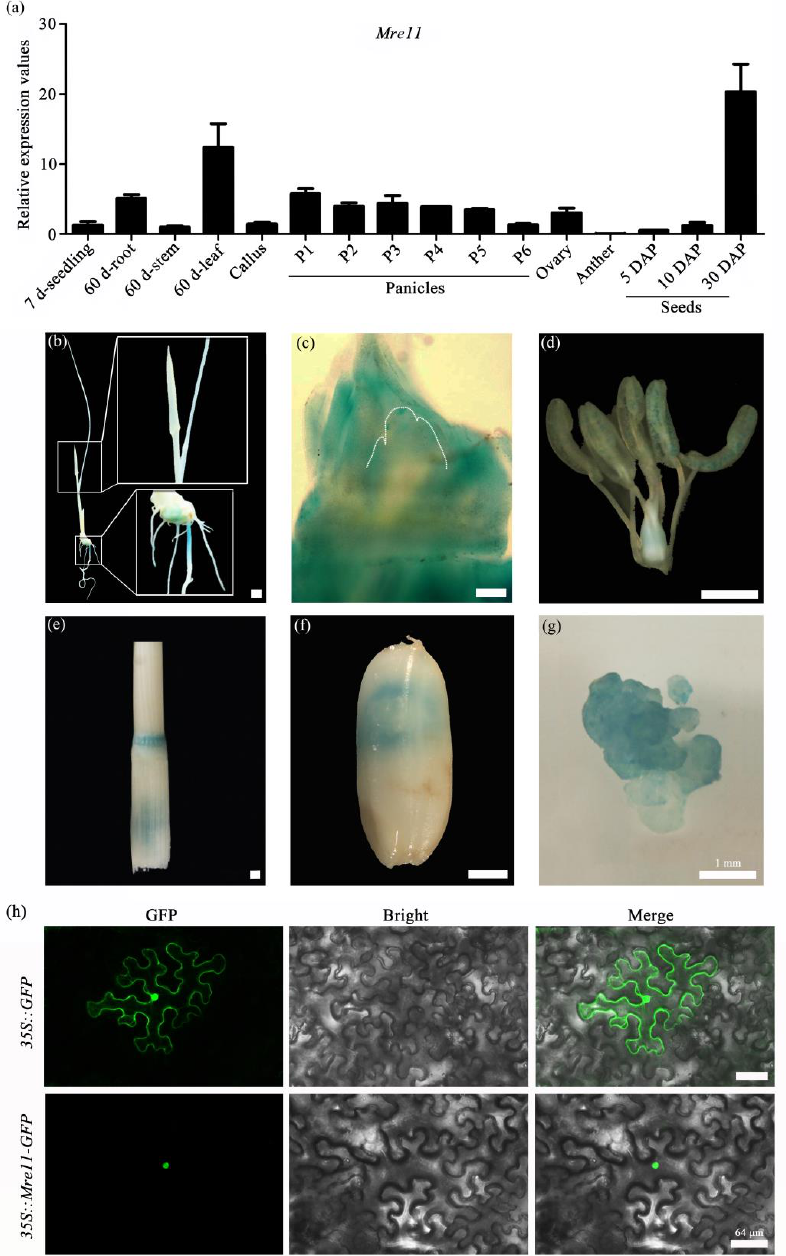
Figure 1. Expression pattern of OsMre11 gene in rice. Expression pattern of OsMre11 gene in rice. ( a ) Expression level of OsMre11 gene in 7-day-old seedling, 60-day-old root, 60-day-old stem, 60-day-old leaf, callus, panicles (P1: 0 – 3 cm spikelet; P2: 3 – 5 cm spikelet; P3: 5 – 10 cm spikelet; P4: 10 – 15 cm spikelet; P5: 15 – 22cm spikelet; P6: 22-30cm spikelet), ovary, anther, and seeds (5DAP: 5 days after pollination; 10DAP: 10 days after pollination; 30DAP: 30 days after pollination). ( b – g ) GUS ( β -Galactosidase) expression pattern in different tissues and organs. GUS expression in 7-day-old seedling after germination ( b ), shoot apical meristem ( c ), pistil and stamen ( d ), 60-day-old stem ( e ), mature seed ( f ), transgenic positive callus ( g ). ( b , d – g ) Scale bars represent 1 mm. ( c ) Scale bar represents 0.1 mm. ( h ) Subcellular localization of OsMre11 in tobacco epidermal cells. The 35S::GFP was used as a negative control. Scale bars represent 64 µ